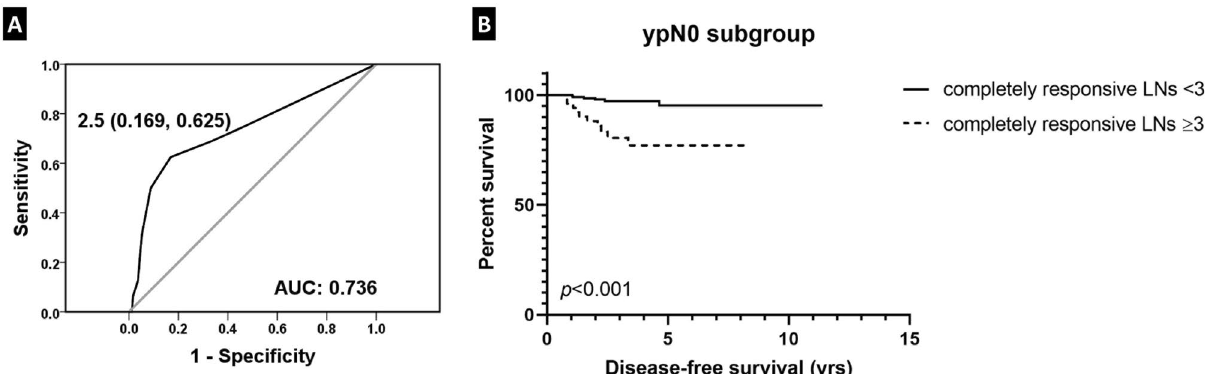
Figure 4. Disease-free survival based on the number of completely-responsive lymph nodes (LNs). (A) A receiver operating characteristic curve analysis yields the highest area under curve (AUC) at a value of 2.5 as the cutoff for the number of completely-responsive LNs. (B) In ypN0 subgroup, patients with a number of completely-responsive LNs less than 3 show longer disease-free survival compared to those having a completely- responsive LN number greater than or equal to 3.